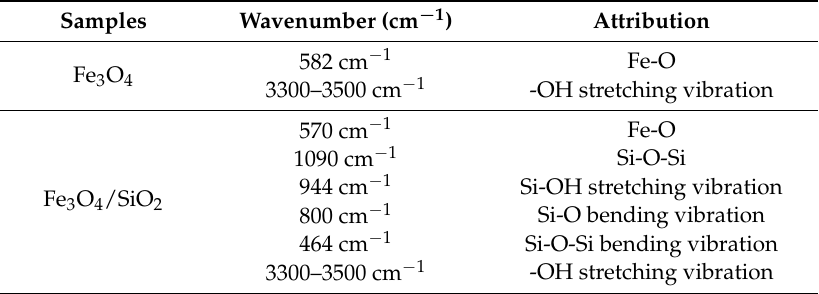
Figure 3. The FTIR spectra of Fe 3 O 4 MNPs and Fe 3 O 4 /SiO 2 MNPs. Table 1. FTIR data of Fe 3 O 4 MNPs and Fe 3 O 4 /SiO 2